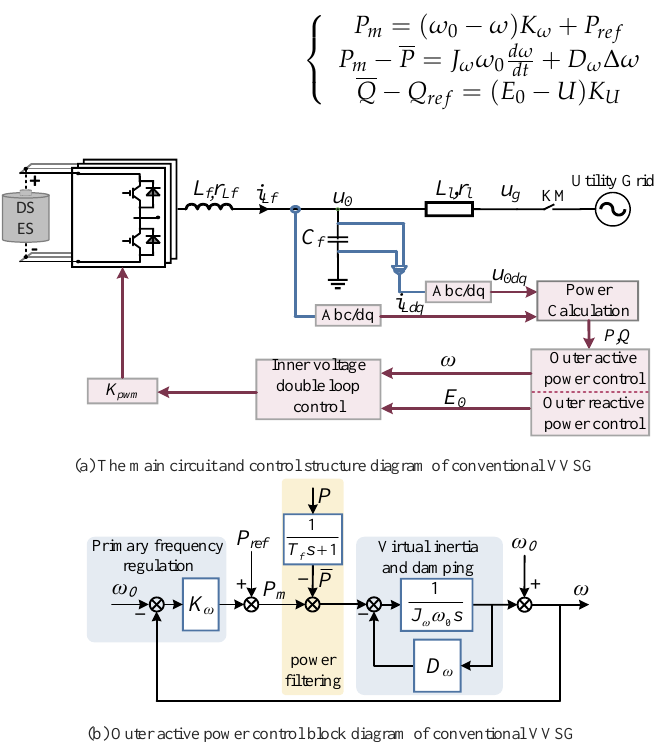
Figure 1. The main circuit and control structure diagram of conventional VVSG. ( a ). The main circuit and control structure diagram. ( b ). The closed-loop control block diagram of VVSG output active power.